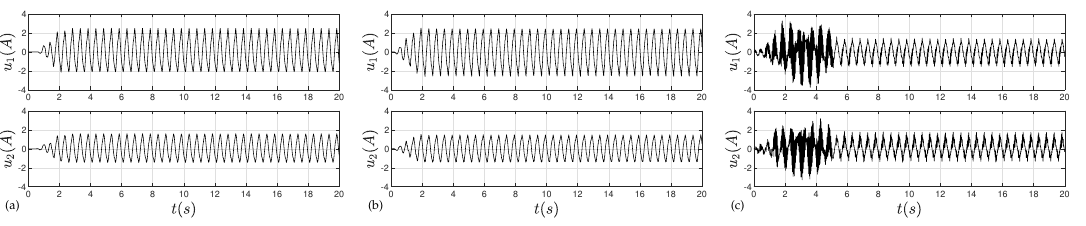
Figure 12. Controller output under low-frequency excitation. ( a ) PD; ( b ) CCC; ( c ) ARSCR.